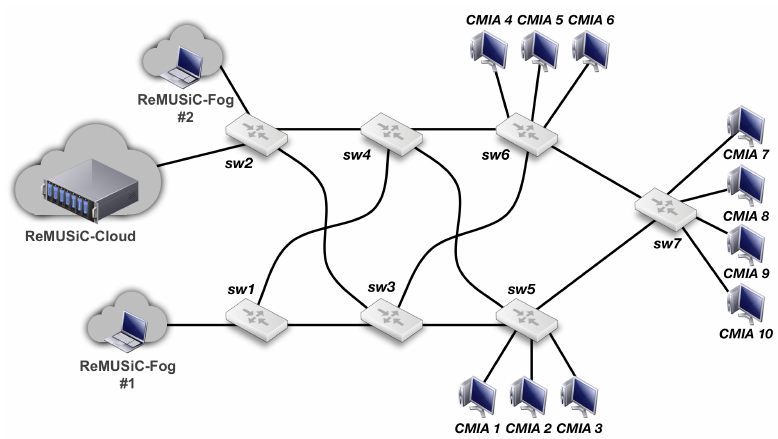
Figure 9. Testbed topology corresponding to the evaluation